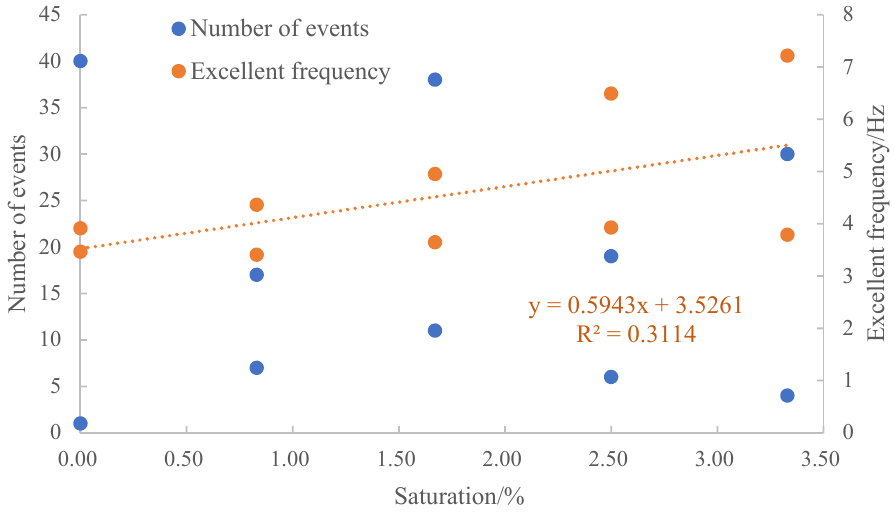
Figure 11. Relationship of number and average excellent frequency of infrasound events with water saturation.